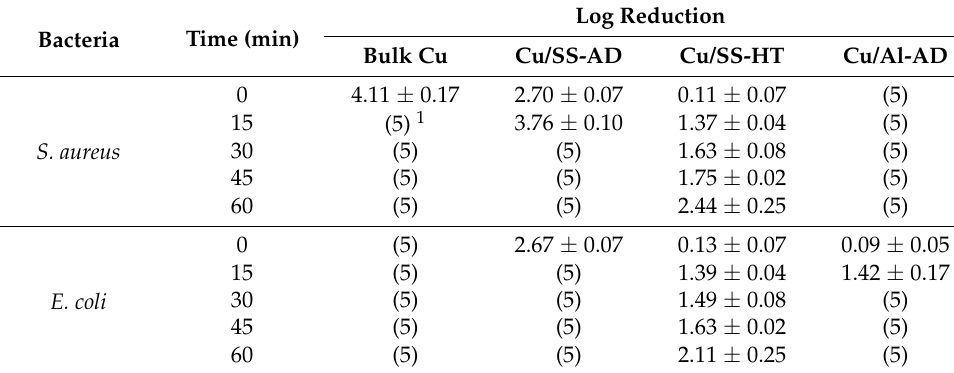
Table 4. Antibacterial efficacy of various samples against S. aureus and E. coli. (data represent average value of log reduction ± standard deviation).